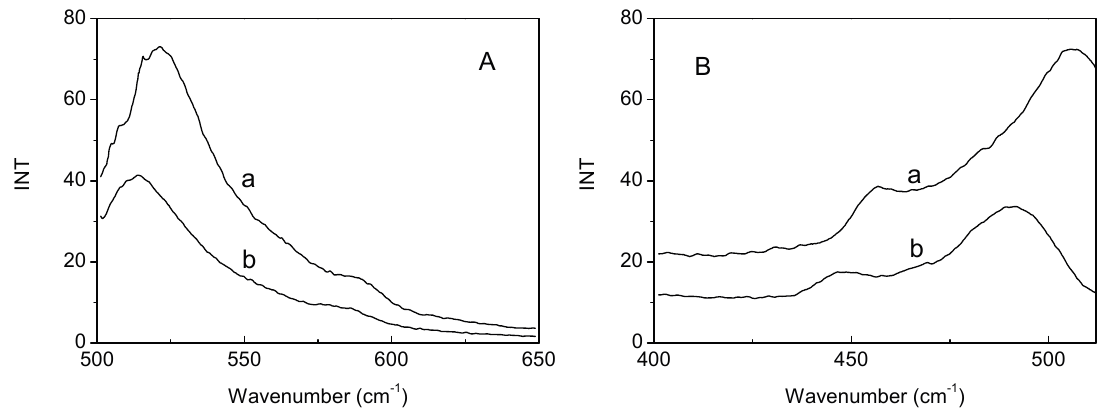
Figure 1. FTIR spectra of (a) PLA and (b) collagen-PLA.